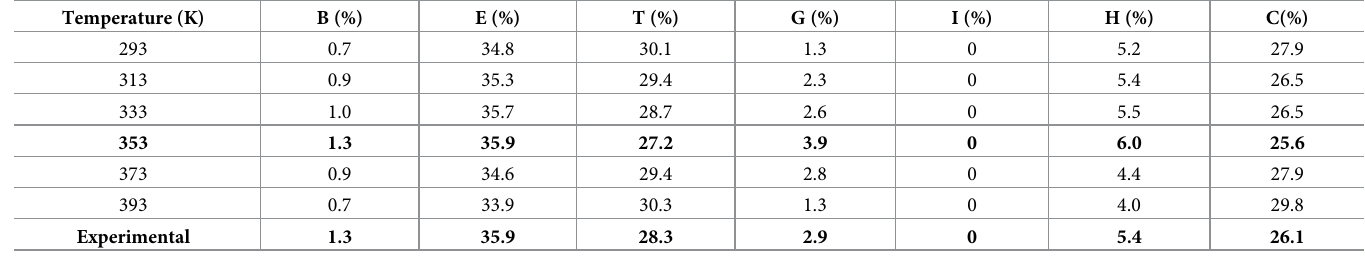
Table 1. Percentage contribution of secondary structure contents in SazCA as a function of temperature obtained from MD simulations, where B, E, T, G, I, H, C represent the amounts of isolated β -sheets, extended conformations ( β -sheets), turns, 3 10 -helices, π -helices, α -helices and coils, respectively. The secondary structure assignment data of crystal structure (experimental) of SazCA have also been shown for